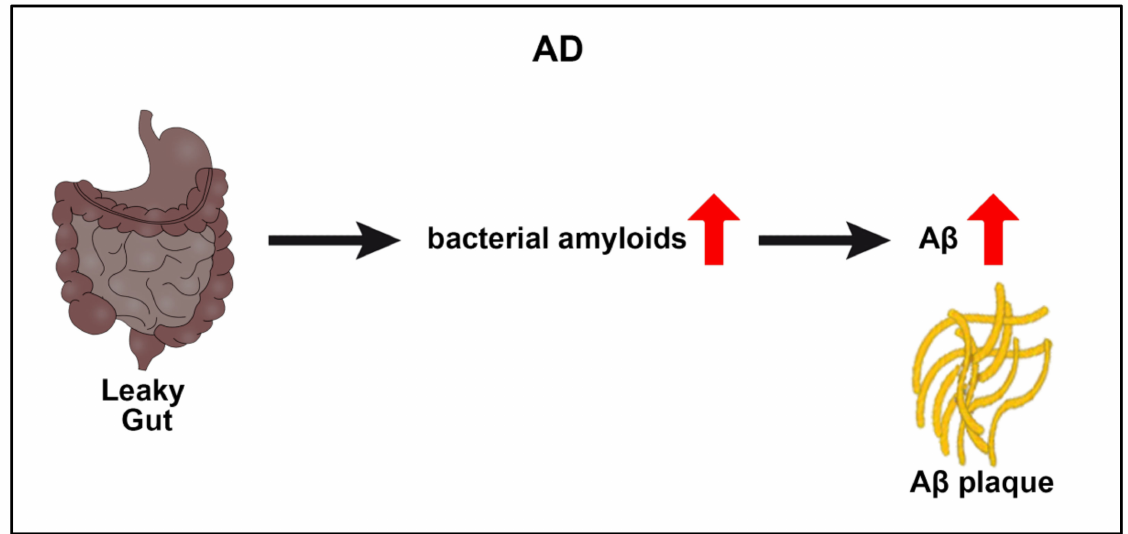
Figure 2. AD and GBA. A leaky gut may allow the transport of bacterial amyloids from the intestines to the brain, where aberrant aggregation of amyloid β (A β ) occurs, forming A β plaques implicated in AD pathology and